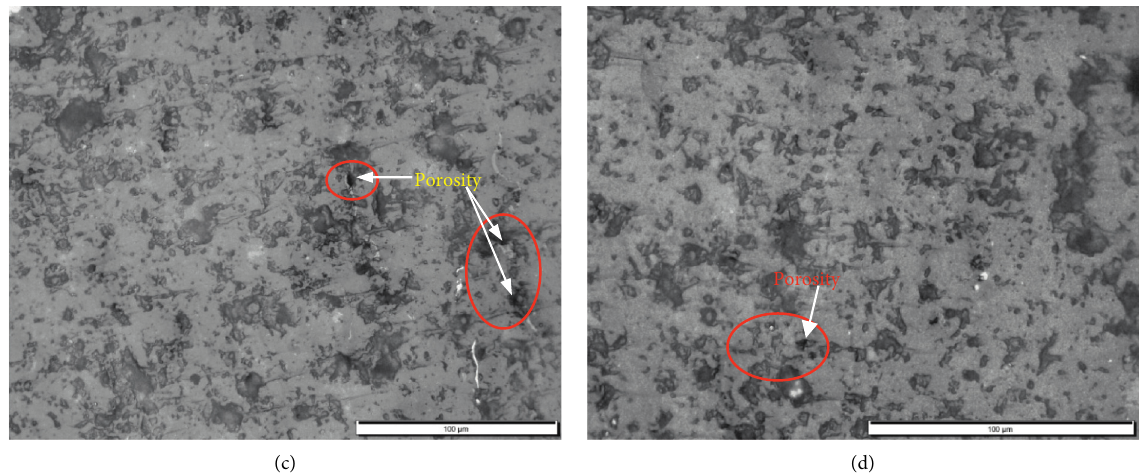
(c) Figure 5: Optical micrographs of (a) Al 2 O 3 +3wt%TiO 2 composite coating without CNTs reinforcement, (b) Al 2 O 3 +3wt%TiO 2 +1% CNTs reinforced coating, (c) Al 2 O 3 +3wt%TiO 2 +3% CNTs reinforced coating, and (d) Al 2 O 3 +3wt%TiO 2 +5% CNTs reinforced